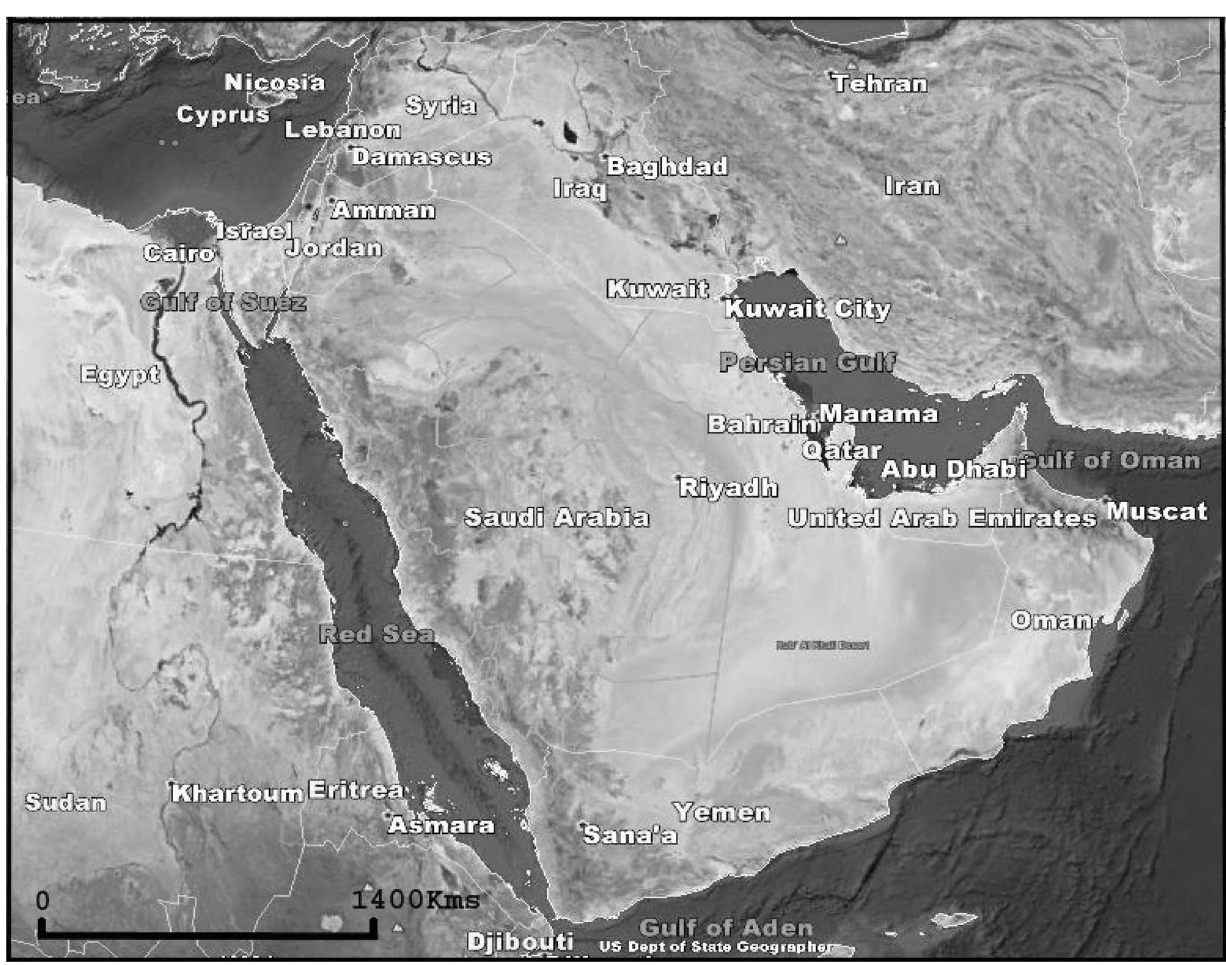
Fig. 1 Google earth map of Gulf countries